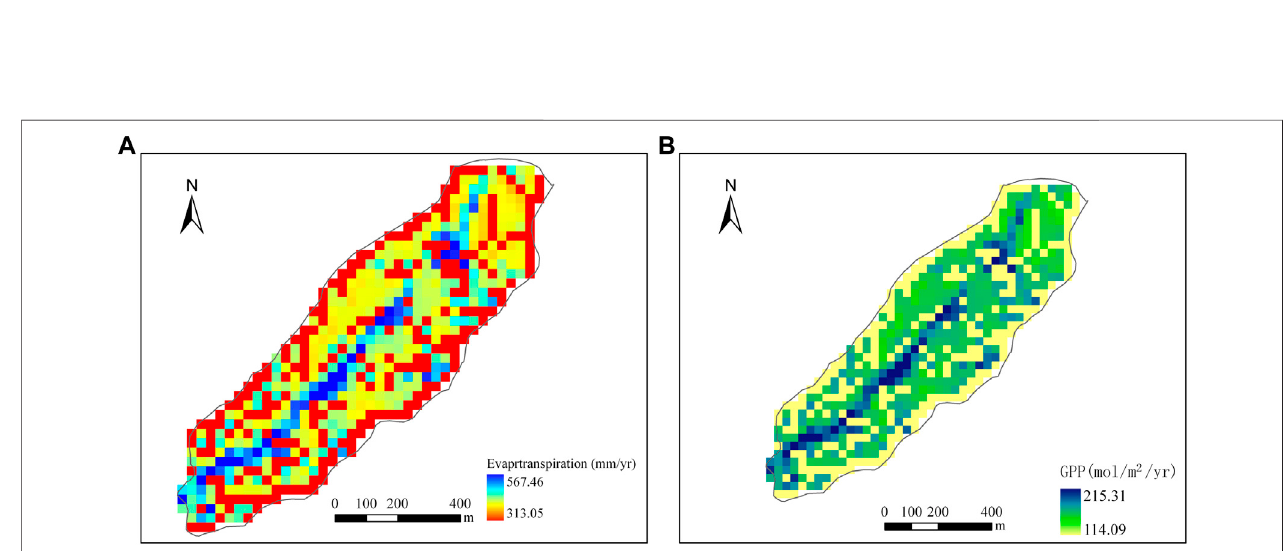
FIGURE 10 | Spatial distribution of ET (A) and GPP (B) simulated by DisVOM and VOM.